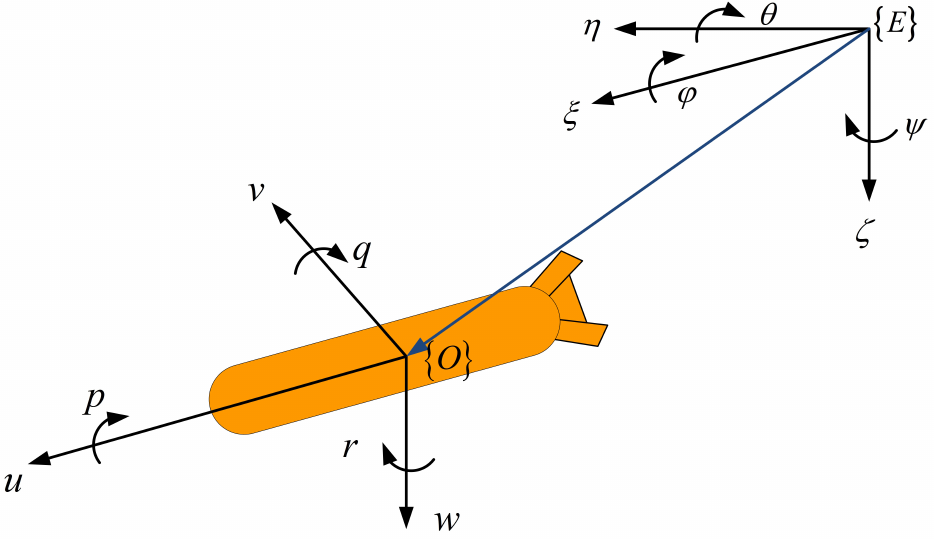
Figure 1. The coordinate system of the